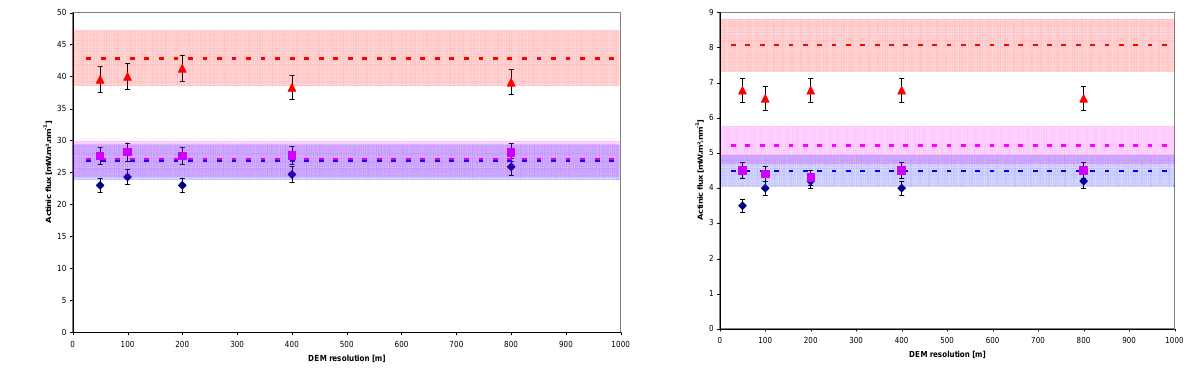
Fig. 14. Modeled 3-D UV Actinic (305nm) calculations for 24 February, 12:30 UTC as a function of DEM resolution. Dotted lines Figure 14: Modeled 3-D UV Actinic (305 nm) calculations for 24 th February, 12:30 UTC as a show the measurements which correspond to the locations and the function of DEM resolution. Dotted lines show the measurements which correspond to the time of calculation. Solar zenith angle is 56.91 degree. The shapes locations and the time of calculation. Solar zenith angle is 56.91 degree. The shapes show the show the model results (diamond=Innsbruck, square=Lans, trian- model results (diamond = Innsbruck, square = Lans, triangle = Hafelekar). The error bars gle=Hafelekar). The error bars show the accuracy of the model show the accuracy of the model simulations (±5%). The coloured areas around the lines of simulations ( ± 5%). The coloured areas around the lines of mea- measurements indicate the measurement uncertainty (=±10%). surements indicate the measurement uncertainty (= ± 10%).